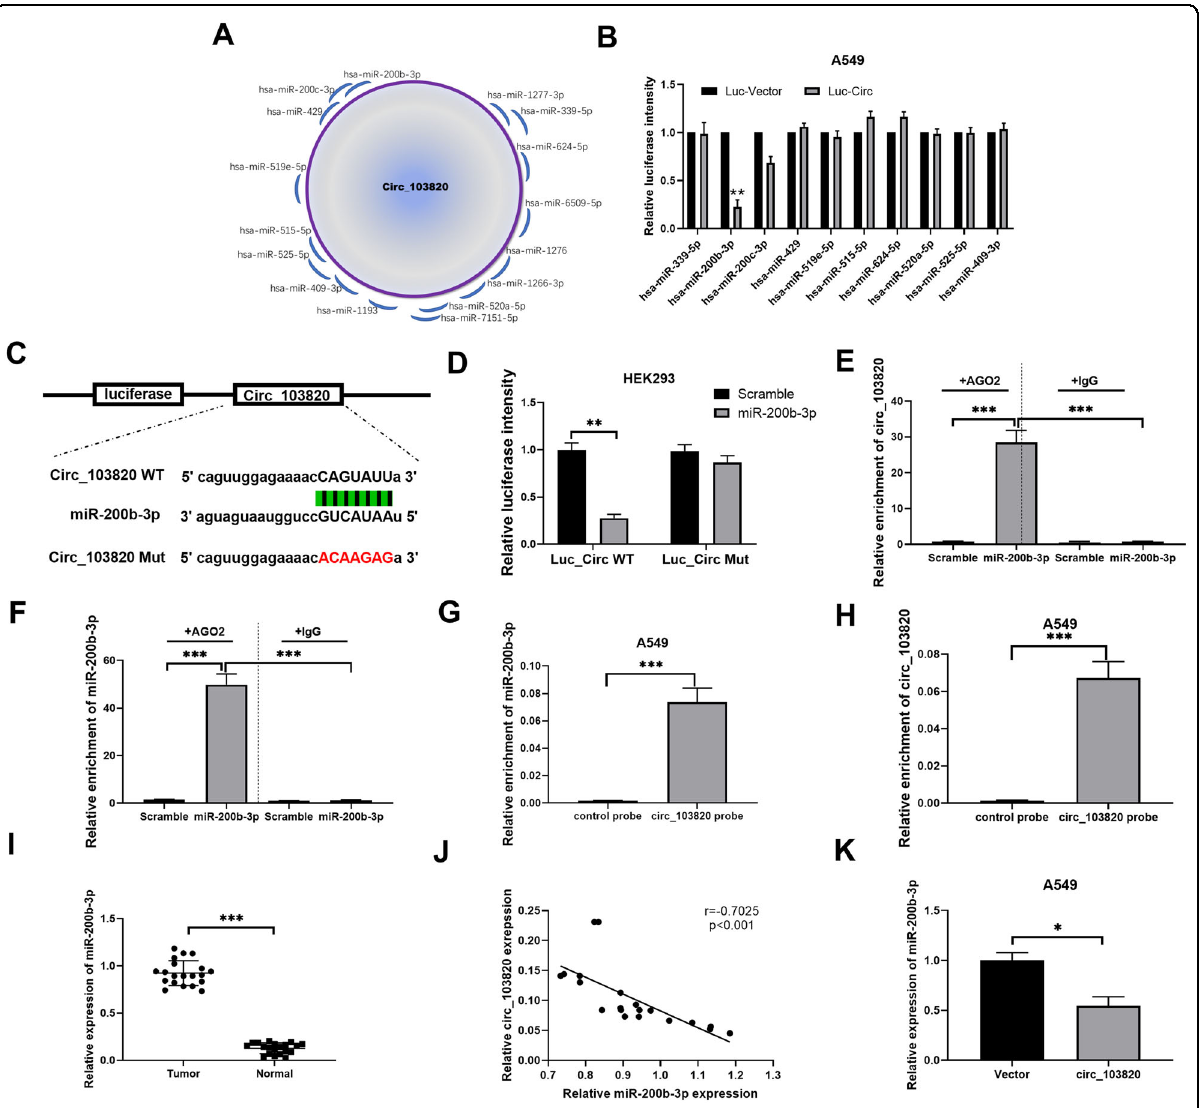
Fig. 5 miR-200b-3p was veri fi ed as a direct target of hsa_circ_103820. A The potential target miRNAs of hsa_circ_103820 were displayed after prediction with starBase v3.0. B The top 10 miRNAs were validated through a luciferase reporter gene assay. C A schematic diagram of the binding site of miR-200b-3p is shown. D WT-hsa_circ_103820 or Mut-hsa_circ_103820 and miR-200b-3p mimics were cotransfected into HEK-293T cells, and a luciferase reporter gene assay was utilized to evaluate luciferase activity. E, F The enrichment of hsa_circ_103820 and miR-200b-3p was con fi rmed using the Ago2-IP assay. G, H RNA pull-down assays were applied to verify the enrichment of hsa_circ_103820 and miR-200b-3p in A549 cells. I We also adopted a qRT-PCR assay to assess miR-200b-3p expression in paracarcinoma tissues and lung cancer tissues. J Correlation analysis of hsa_circ_103820 and miR-200b-3p (r = -0.7025, P < 0.001). K Relative expression levels of miR-200b-3p were analyzed by qRT-PCR assay in circ_103820-overexpressing A549 cells and vector control cells (* P <